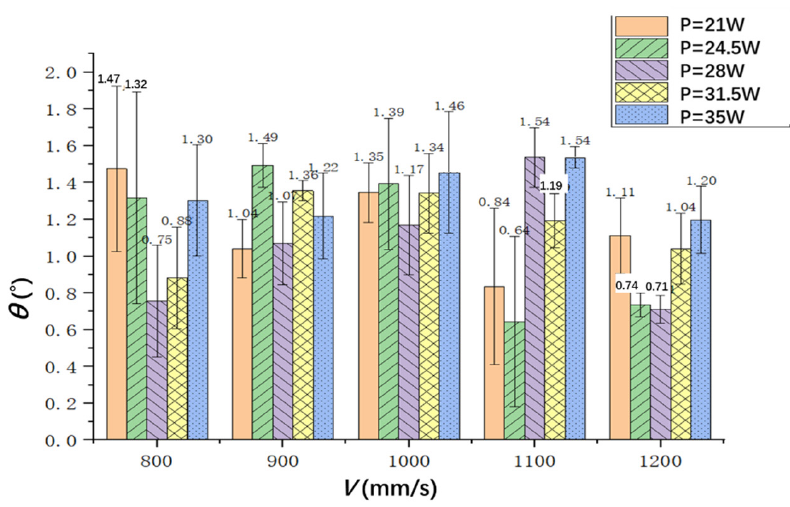
Figure 9. The hole taper with different laser powers and scanning speeds.